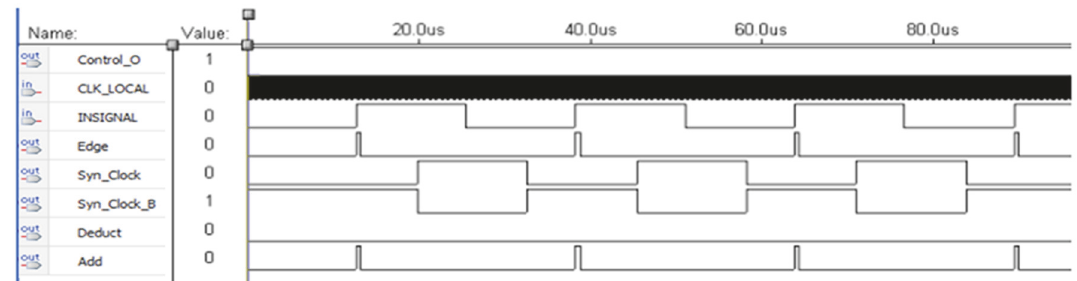
Figure 4: Simulation result of differential phase detector in phase lead.